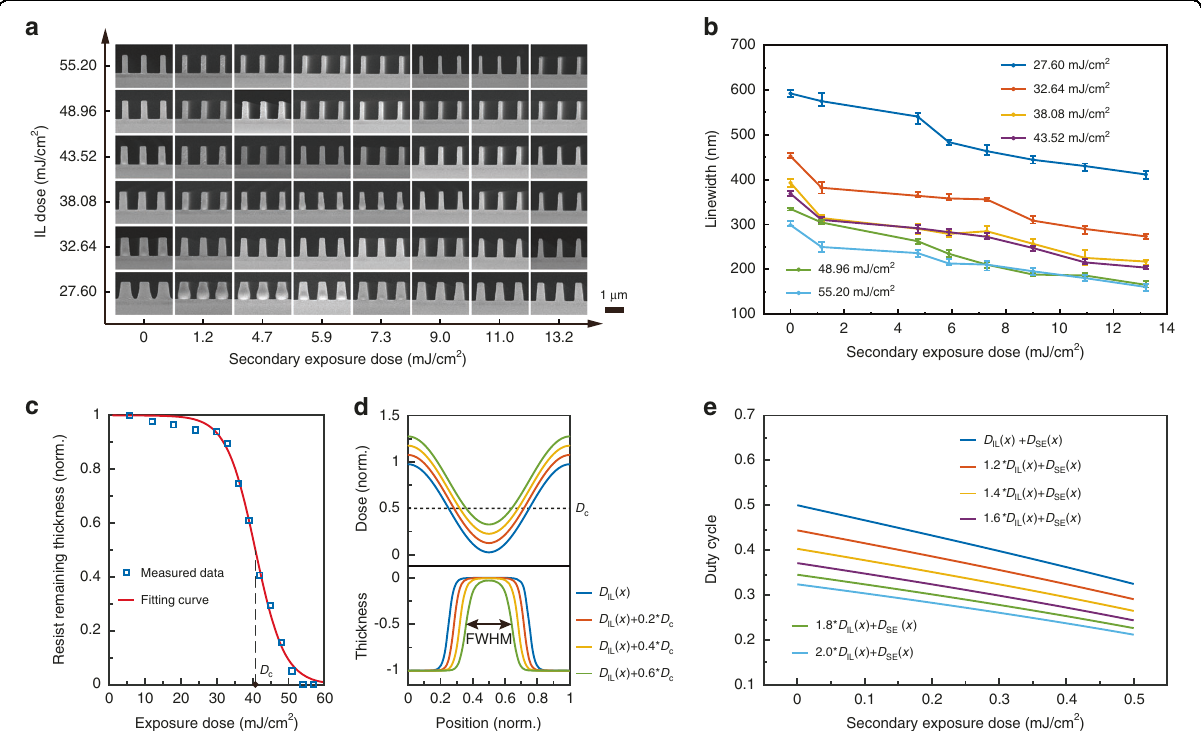
Fig. 2 Experimental results and numerical model of feature size modulation by SE. a SEM image matrix of 1000-nm-period gratings with various linewidths fabricated by different IL and secondary exposure doses. b The FWHM linewidths measured in a , showing the linewidth is negatively correlated to both IL and secondary exposure doses. c Normalized measured photoresist remaining thickness as a function of exposure dose (blue squares) and the corresponding best- fi tting curve (red line). d Simulation of the total exposure dose distribution and resulting developed photoresist pro fi les by setting photoresist contrast as extracted from c and contrast of IL exposure dose distribution as 0.95. e The simulated duty cycle variation as a function of the secondary exposure dose using various initial IL exposure